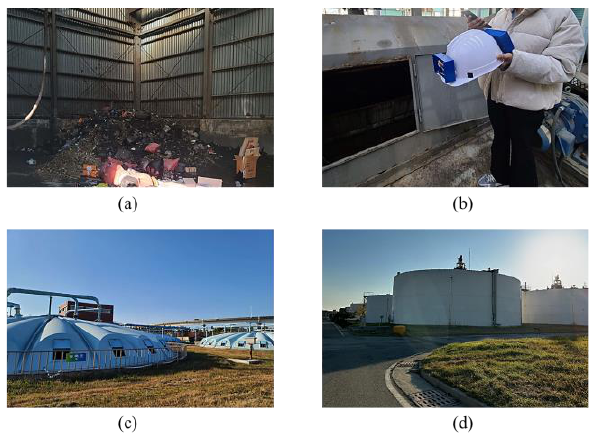
Figure 10. Data collection units in the wastewater treatment plant ( a ) landfill area, ( b ) primary sedimentation tank, ( c ) secondary clarifier, and ( d ) sludge digestion tank.